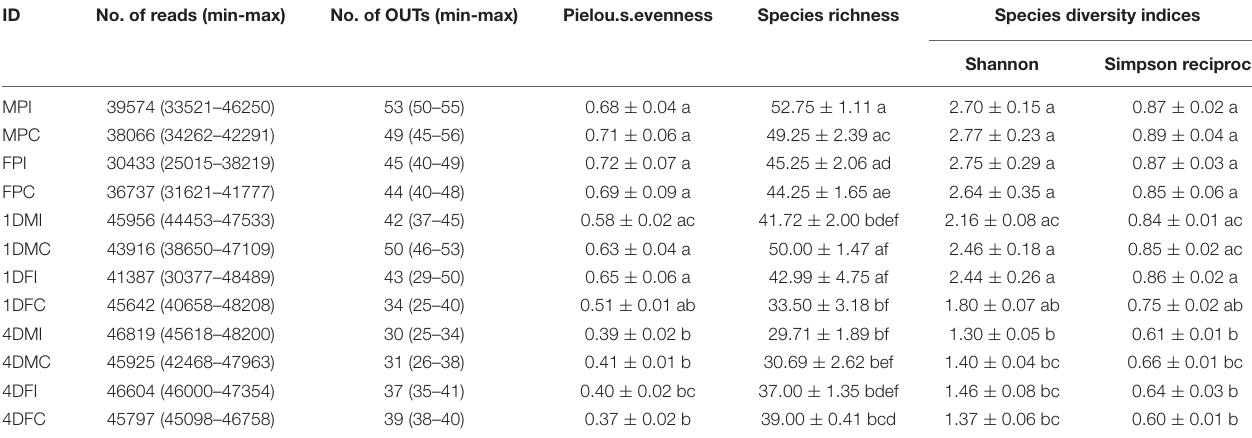
TABLE 1 | Analysis of α diversity indices of the experimental samples. ID No. of reads (min-max) No. of OUTs (min-max)